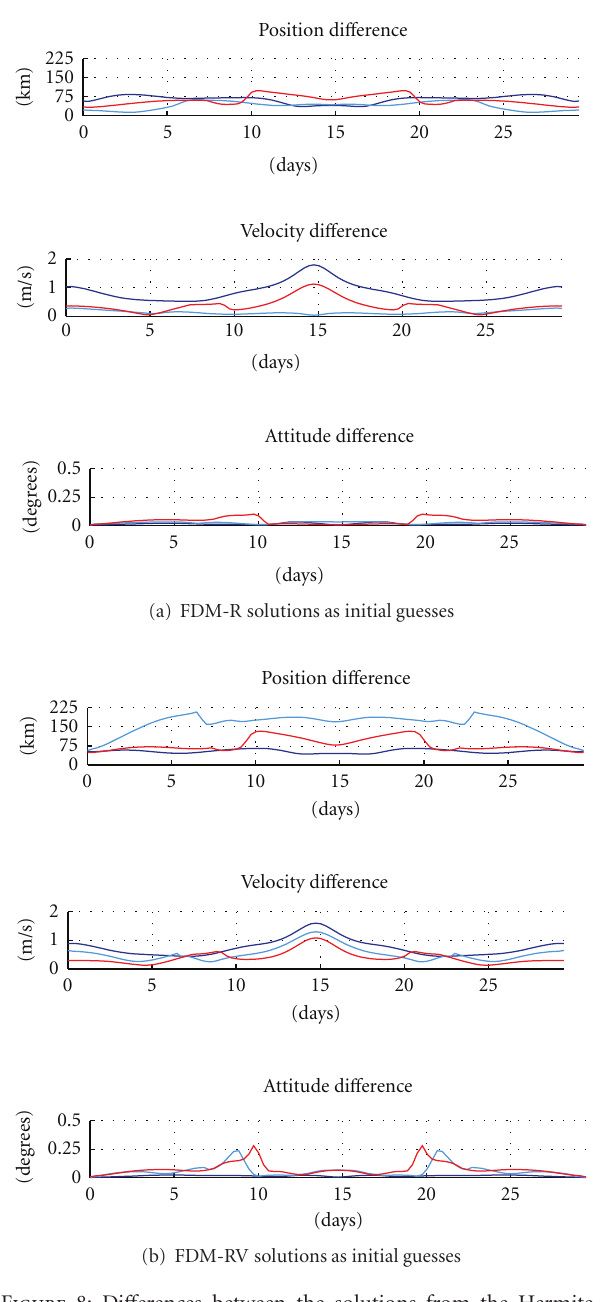
Figure 8: Di ff erences between the solutions from the Hermite- Simpson method and their initial guesses supplied by the FDM-R (a) and FDM-RV (b)